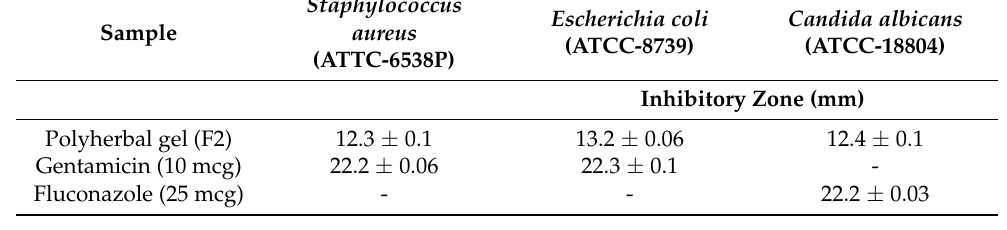
Table 3. Antimicrobial activity of the extract of Vigna radiata.